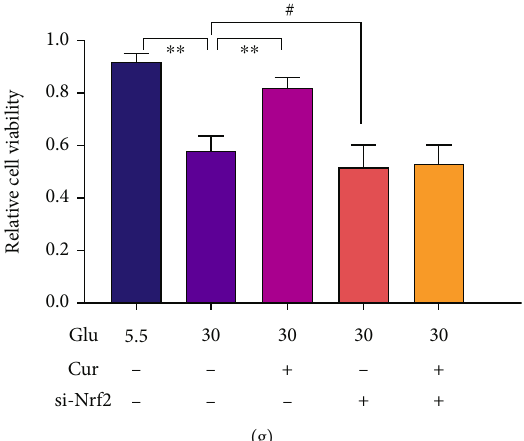
Figure 5: Interfering with the expression of Nrf2 hinders the cardioprotective e ff ect of curcumin. Glu: glucose; Cur: curcumin; the dose of curcumin used in cell experiments is 14 μ M. Si-Nrf2: interference virus vector targeting the Nrf2 gene. (a) PCR and western blotting detection of intracellular Nrf2 expression. (b) Western blotting detection of pyroptosis protein expression levels. (c) Western blotting detection of protein expression levels in the AKT/Nrf2 pathway. (d) Immuno fl uorescence detected the fl uorescence intensity of NLRP3 (20x). (e) Changes in the mitochondrial membrane potential levels of cardiomyocytes. The stronger the red fl uorescence, the worse the cell viability; the stronger the green fl uorescence, the better the cell viability (20x). (f) TUNEL fl uorescent probe to detect the incidence of apoptosis (20x). (g) The CCK-8 test detects cardiomyocyte activity. ∗∗ P < 0 : 001 , high-glucose group vs. normal group and curcumin- treated group. # ∗ P < 0 : 001 : transfected siRNA vs. untransfected cells (in high-glucose medium). # P < 0 : 05 : transfected siRNA vs. untransfected cells (in high-glucose medium). Values are expressed as the mean ± standard